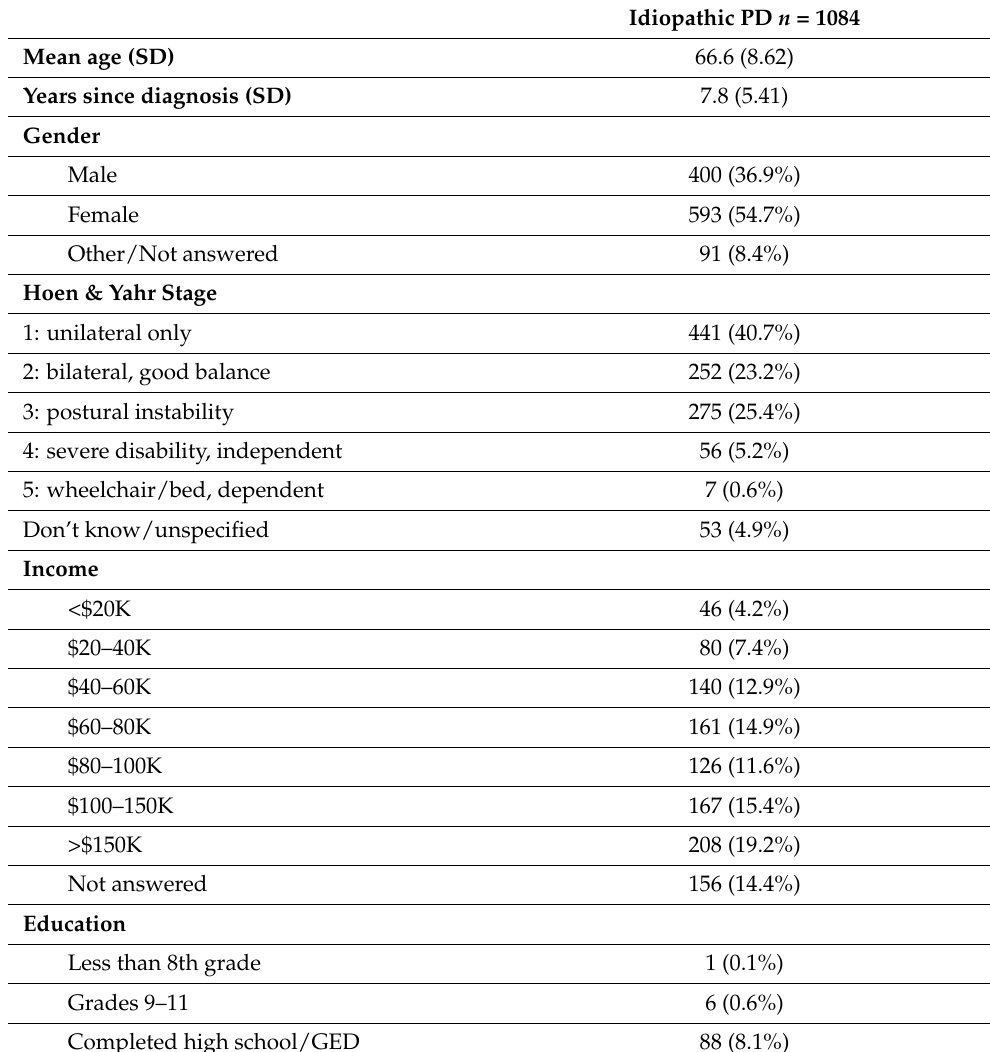
Table 1. Descriptive statistics of the study cohort with n and sample